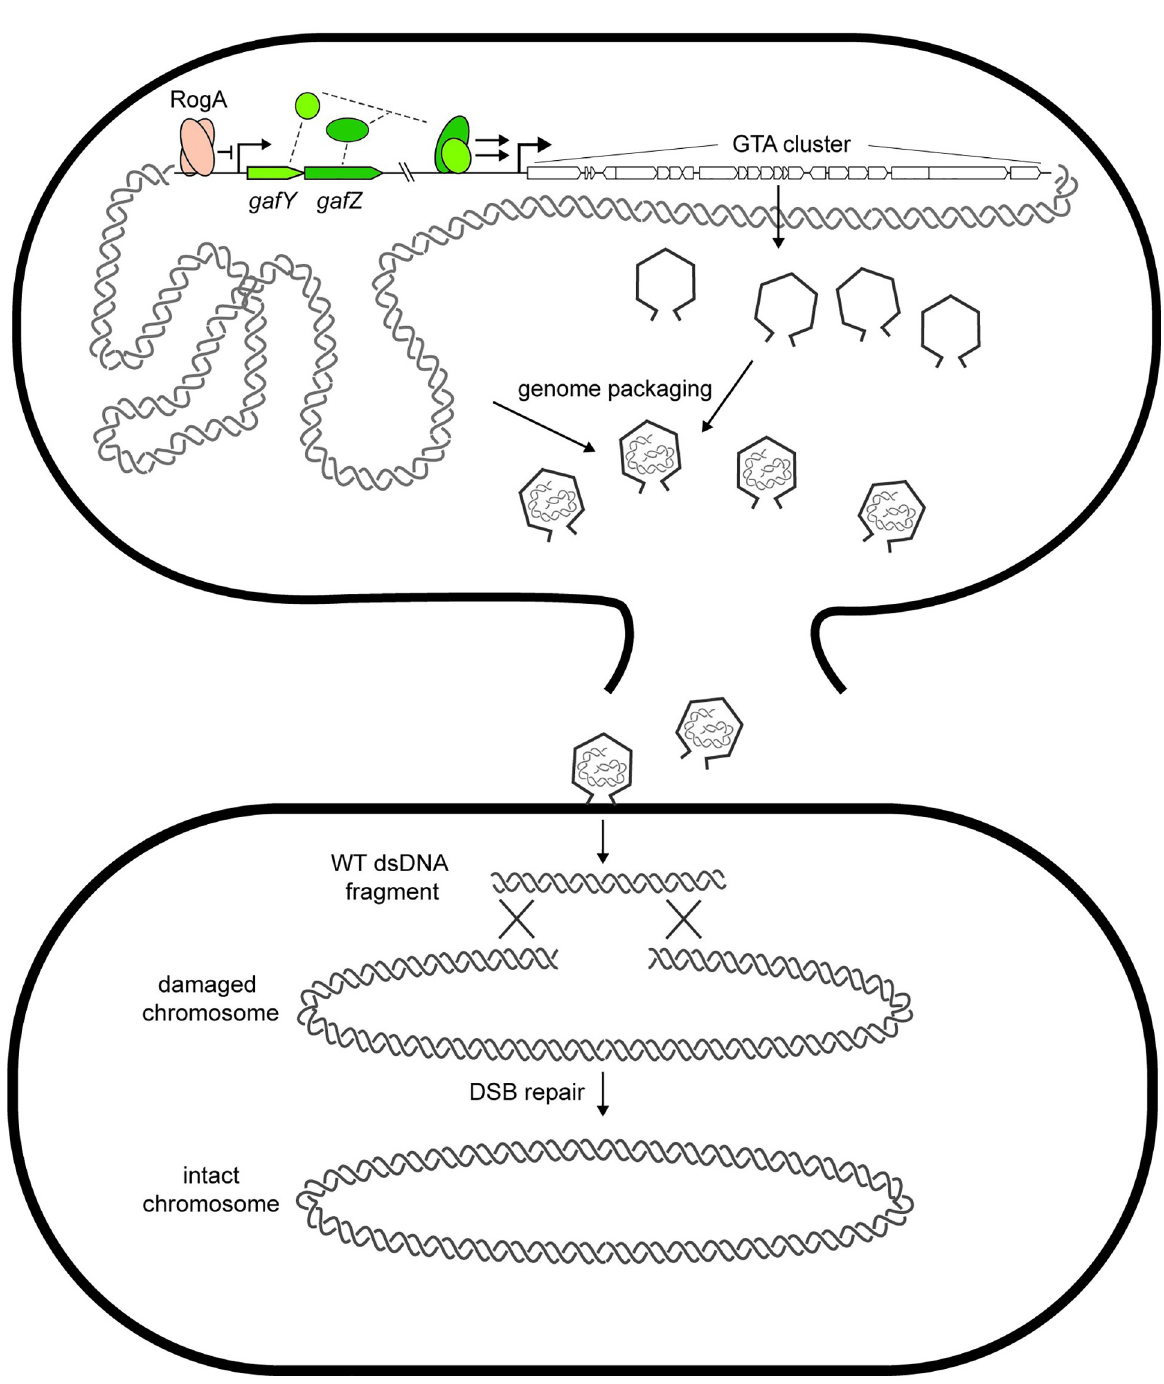
Fig 7. Model schematic of GTA production in Caulobacter crescentus . RogA directly represses expression from the gafYZ promoter. From some unknown stimulus, RogA is removed from the promoter, leading to transcriptional activation of gafYZ , which are sufficient to induce expression of the GTA cluster and other auxiliary GTA genes. GTA induction leads to production of phage-like particles that are packed with random fragments of genomic DNA. The producer cell then lyses and releases GTA particles into the supernatant that can then transfer wild-type DNA to recipient cells to be used for recombination to fix deleterious mutations or strand breaks. GTA, gene transfer agent.